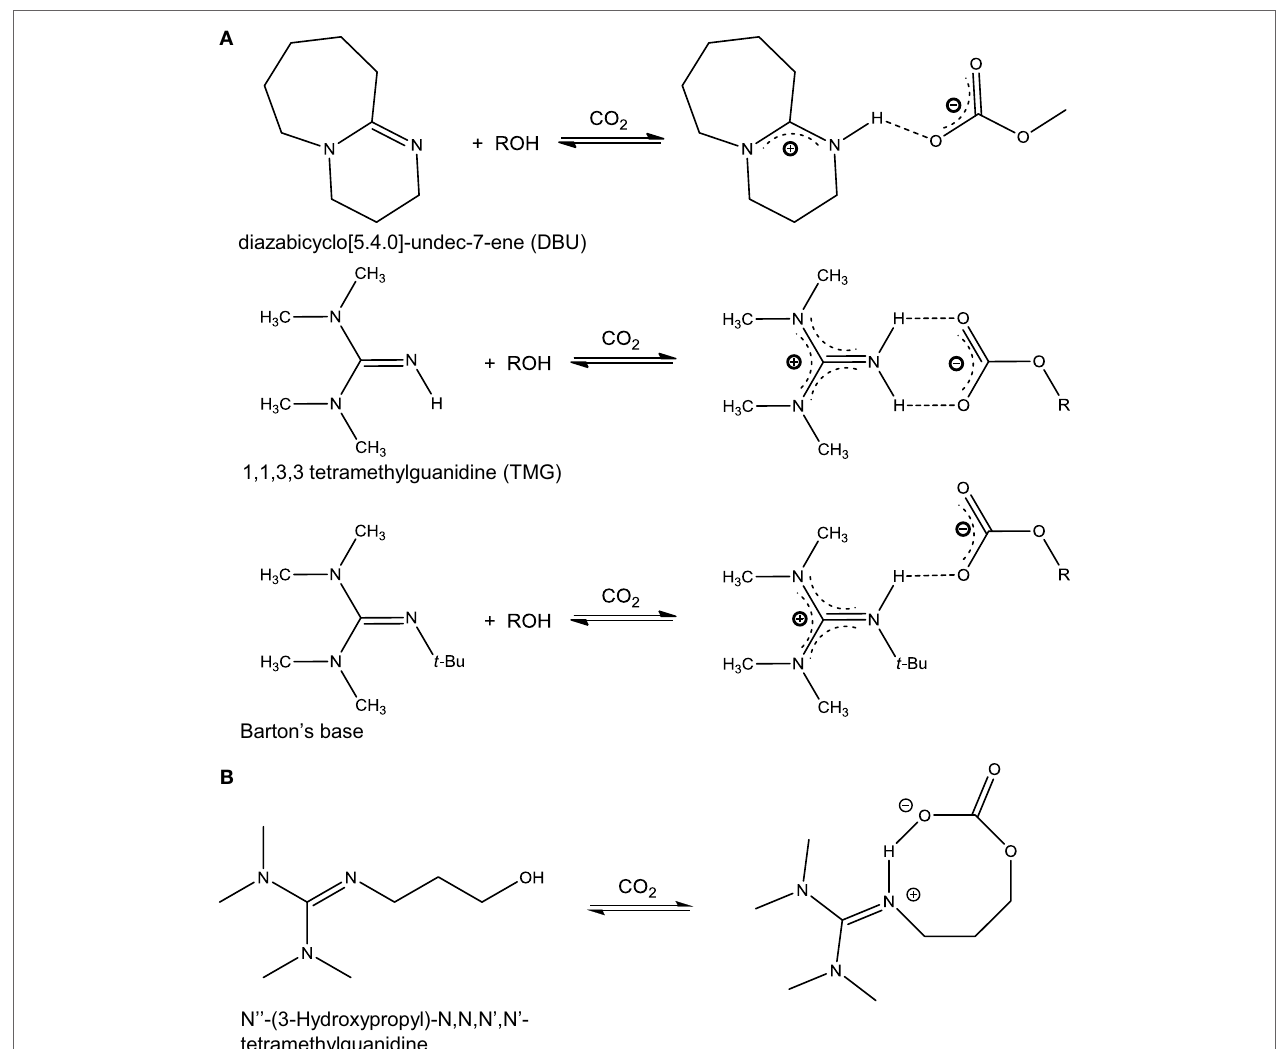
SCHeMe 3 | Reaction between CO 2 and CO 2 BOLs: (A) CO 2 BOLs composed of two species, an alcohol and an amidine (top) or guanidine based (middle and bottom). Reaction with CO 2 leads to the formation of H-bonds [adapted from Heldebrant et al. (2008)]; (B) CO 2 BOLs composed of a single species. Reaction with CO 2 leads to the formation of a zwitterionic species [adapted from Park et al.